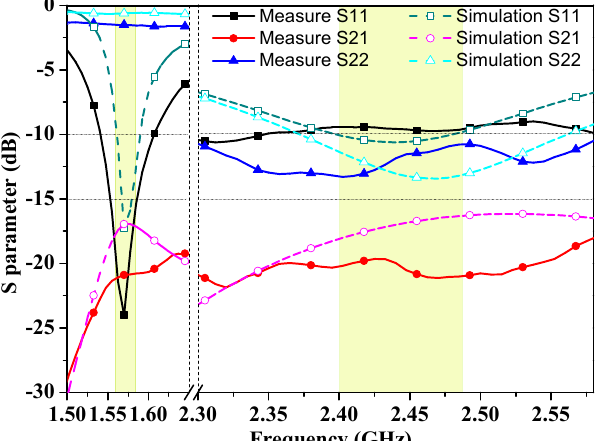
Figure 9. Simulated and measured S parameter of the proposed antenna.